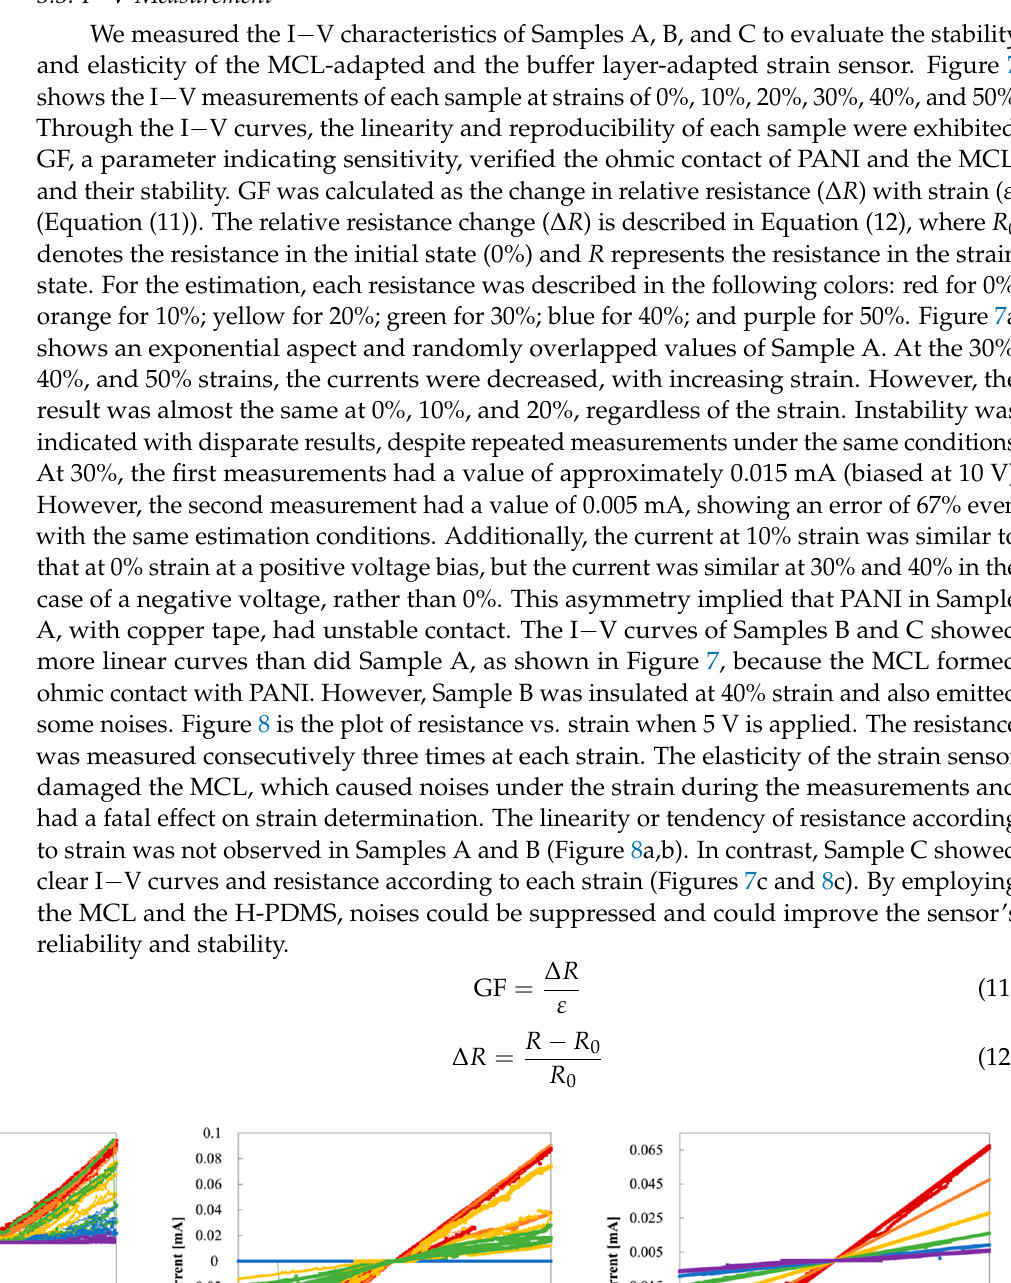
Figure 6. Ag/H-PDMS and Ag-only samples: ( a ) 0% of the Ag/H-PDMS sample; ( b ) 0% of the Ag sample; ( c ) 0% of the Ag/H-PDMS; ( d ) 20% of the Ag/H-PDMS sample; ( e ) 20% of the Ag sample; ( f ) 60% of the Ag/H-PDMS sample; ( g – j ) overall image of the Ag/H-PDMS sample and the measured resistance at ( g ) 0%, ( h ) 20%, ( i ) 40%, and ( j ) 60%.